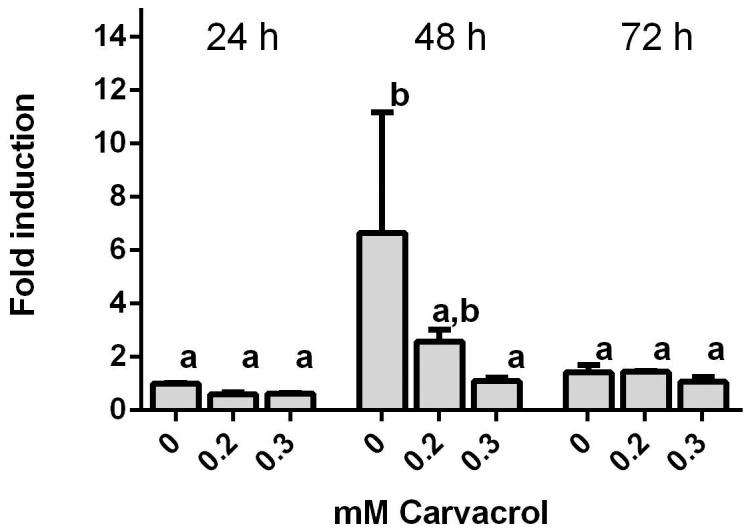
Carvacrol inhibits gene expression of cviI at concentrations too low to influence bacterial growth or survival.Expression of cviI by C. violaceum after incubation with carvacrol for 24, 48 and 72 h. Mean fold increases compared to t = 24 h, 0 mM carvacrol for three experiments are shown. Data points which are significantly different from each other are denoted by different letters (p<0.05). Bars indicate standard error of the mean.